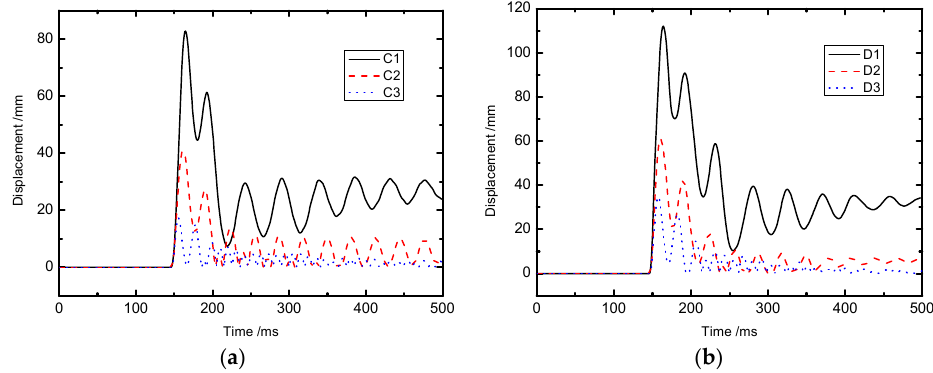
Figure 8. Maximum displacement-time curves with different forehand plate thicknesses. ( a ) Door with stiffeners and ( b ) door with no